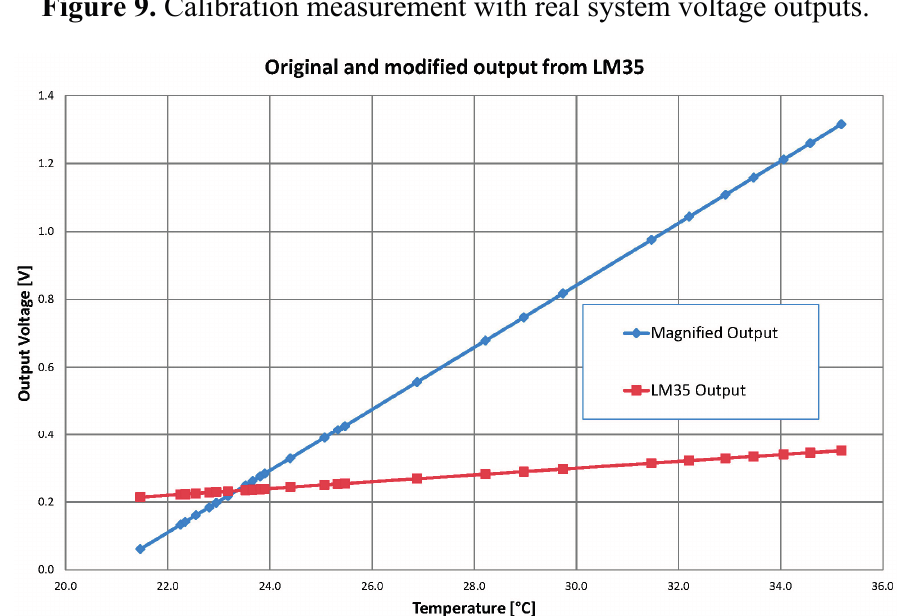
Figure 9. Calibration measurement with real system voltage